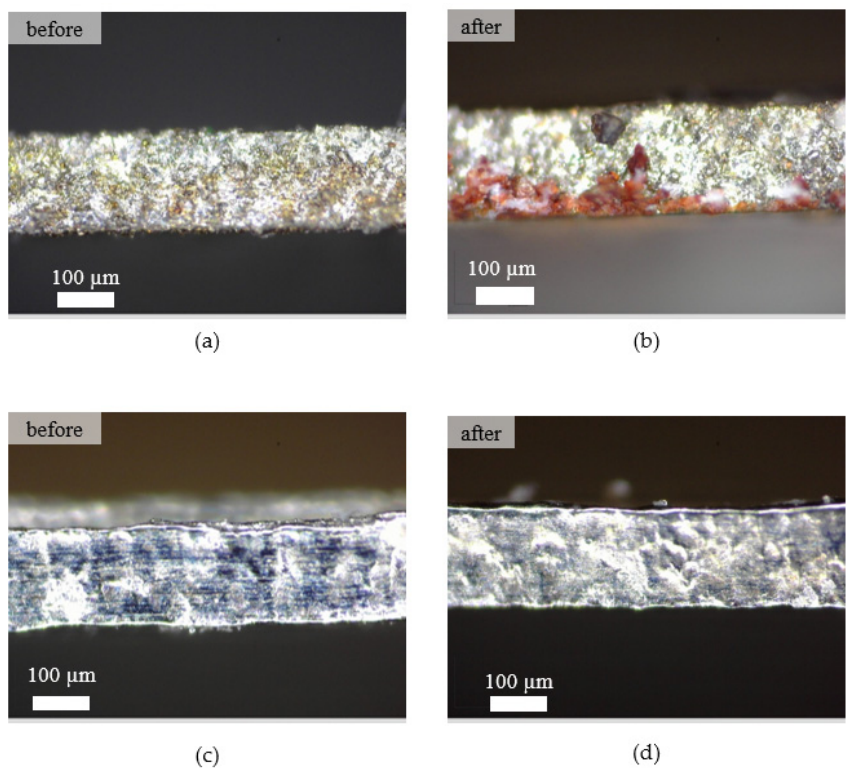
Figure 10. Surface texture of the machined surface. ( a ) Wire EDM before the fouling experiment, ( b ) wire EDM after the fouling experiment, ( c ) EP before the fouling experiment, ( d ) EP after the fouling experiment.